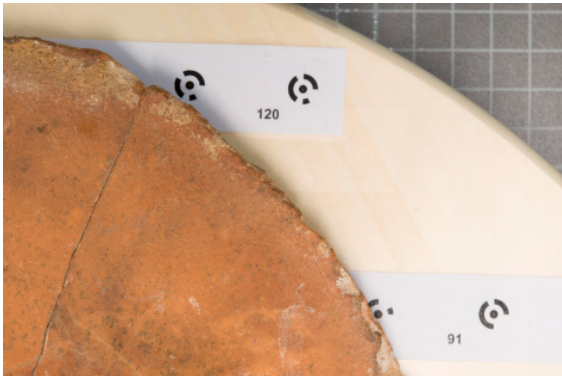
Figure 3. Image of the data collection where the plaquette located on the rotating platform (with coded targets) and this in turn on the reproduction table (grey grid) is observed.